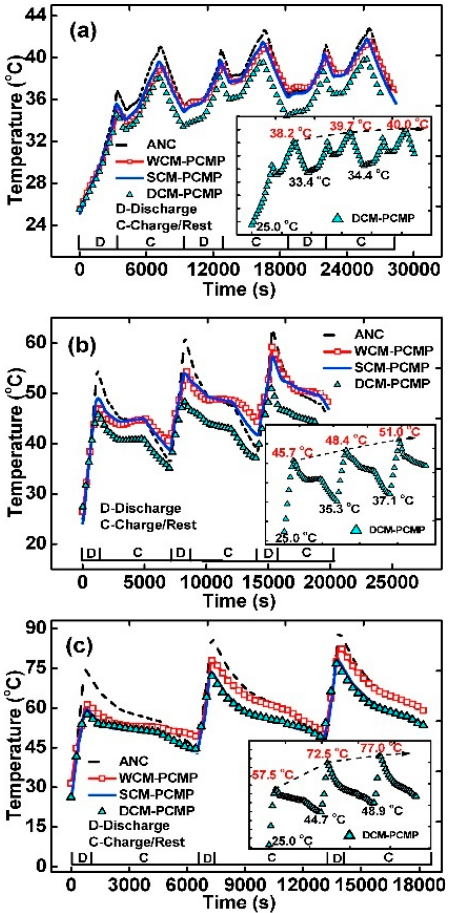
Figure 20. The temperature evolution in the battery module for discharging rates ( a ) 1C, ( b ) 3C and ( c ) 5C [72]. Reproduced with permission from Elsevier.